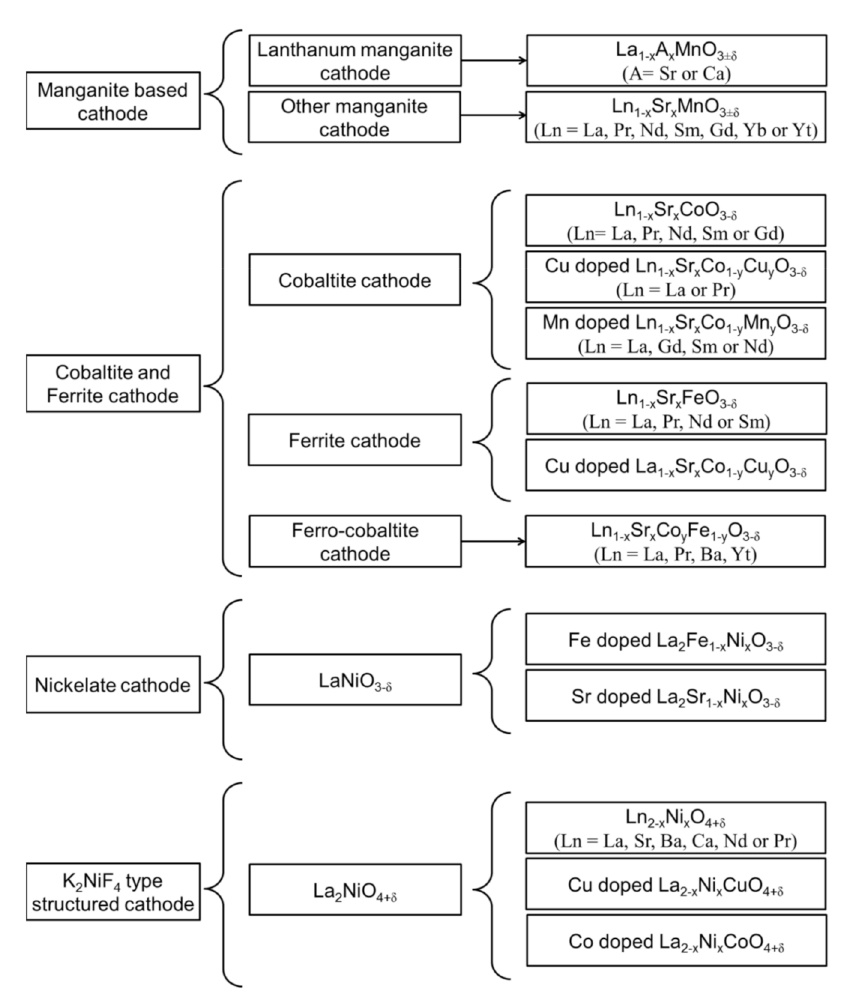
Figure 2. Comprehensive list of various perovskite-based cathode materials used in